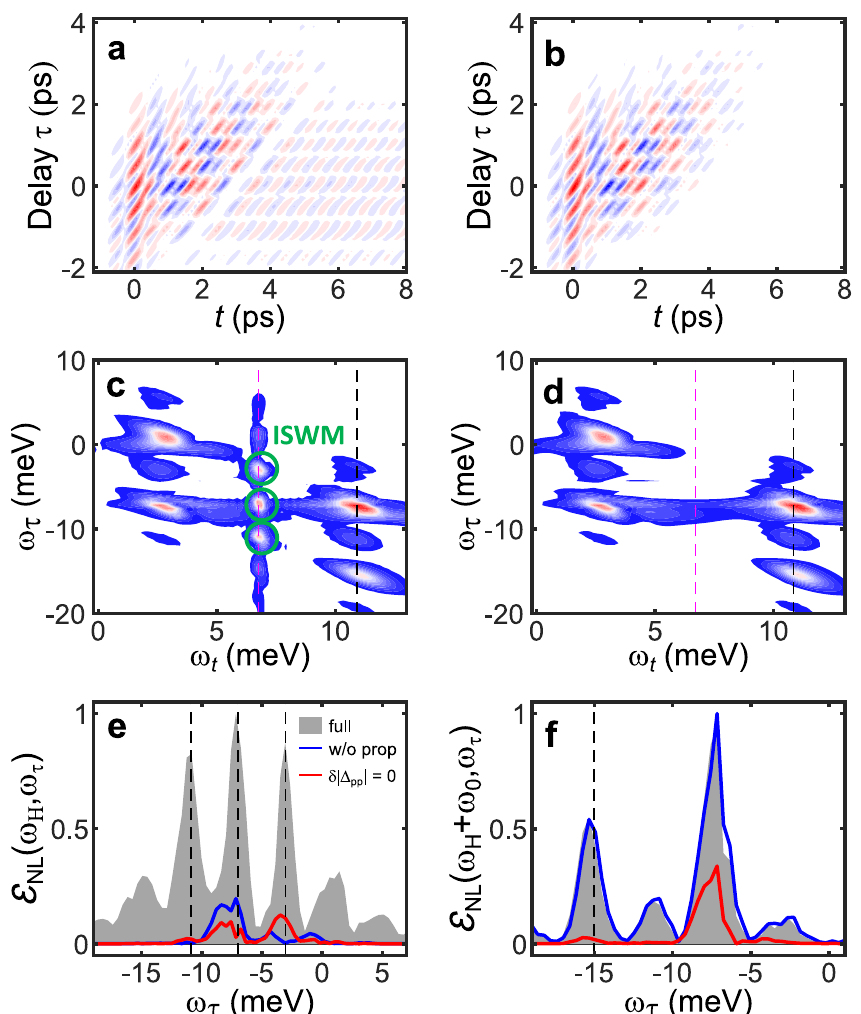
Fig. 4 Quantum sensing of the Higgs collective mode and terahertz (THz) dynamical inversion symmetry breaking in the multi-dimensional THz coherent nonlinear spectra. a , b Correlated differential transmission signal E NL ð t ; τ Þ for calculations with and without electromagnetic propagation effects leading to persistent inversion-symmetry breaking. The signal with propagation effects persists even when the pump and probe pulses do not overlap in time. c , d The corresponding two-dimensional spectra. Green circles indicate the dominant inversion-symmetry breaking signals (ISWM). Lightwave propagation generates a series of inversion-symmetry breaking wave-mixing signals along the ω τ -axis (coherence time) for fi xed ω t = ω H (vertical dashed magenta line) at the Higgs mode frequency in addition to the correlated wave-mixing peaks at ω t = ω H + ω 0 (vertical dashed black line). e , f Slices of E NL for ω t = ω H (vertical magenta dashed line in c and d ) and ω t = ω H + ω 0 (vertical black dashed line in c and d ). The full calculation with lightwave propagation (shaded area) is compared with the calculation without propagation (blue line), and the calculation with propagation but without pump-probe coherent modulation of the order parameter, δ ∣ Δ pp ∣ = 0 (red line). Vertical dashed lines indicate dominant inversion-symmetry breaking wave-mixing ( e ) and correlated wave mixing (CWM) ( f ) signals. The correlated high-order wave mixing peak at ω t = ω H + ω 0 is not affected by propagation-induced inversion symmetry-breaking effects, while the inversion-symmetry breaking wave-mixing signals at the Higgs mode frequency ω t = ω H vanish when propagation effects and/or δ ∣ Δ pp ∣ are switched